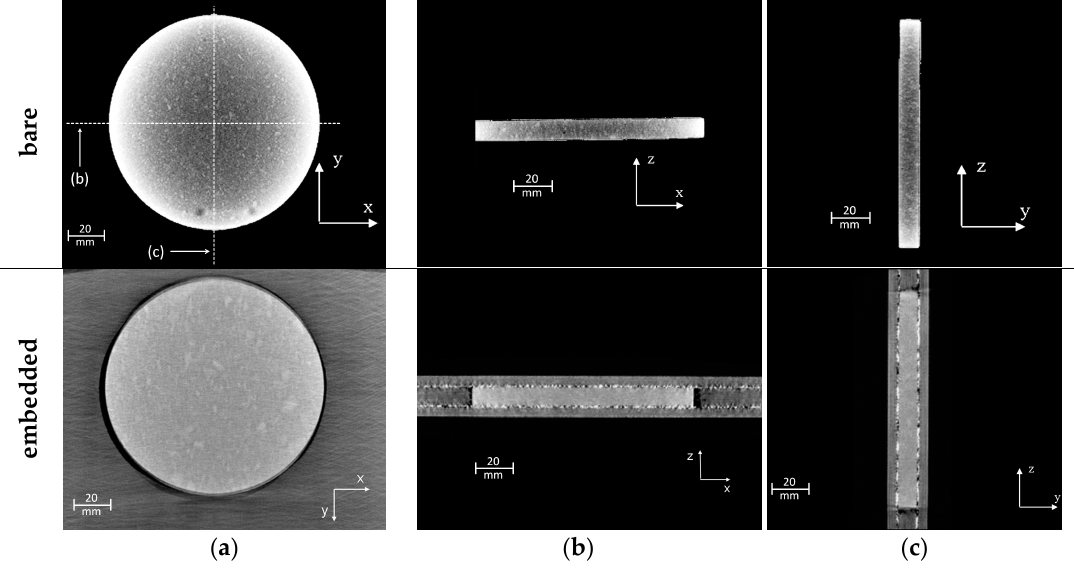
Figure 6. CT Images showing a bare pellet (upper row) and an embedded pellet (lower row): ( a ) xy -cross section; ( b ) xz -cross section; ( c ) yz -cross section.